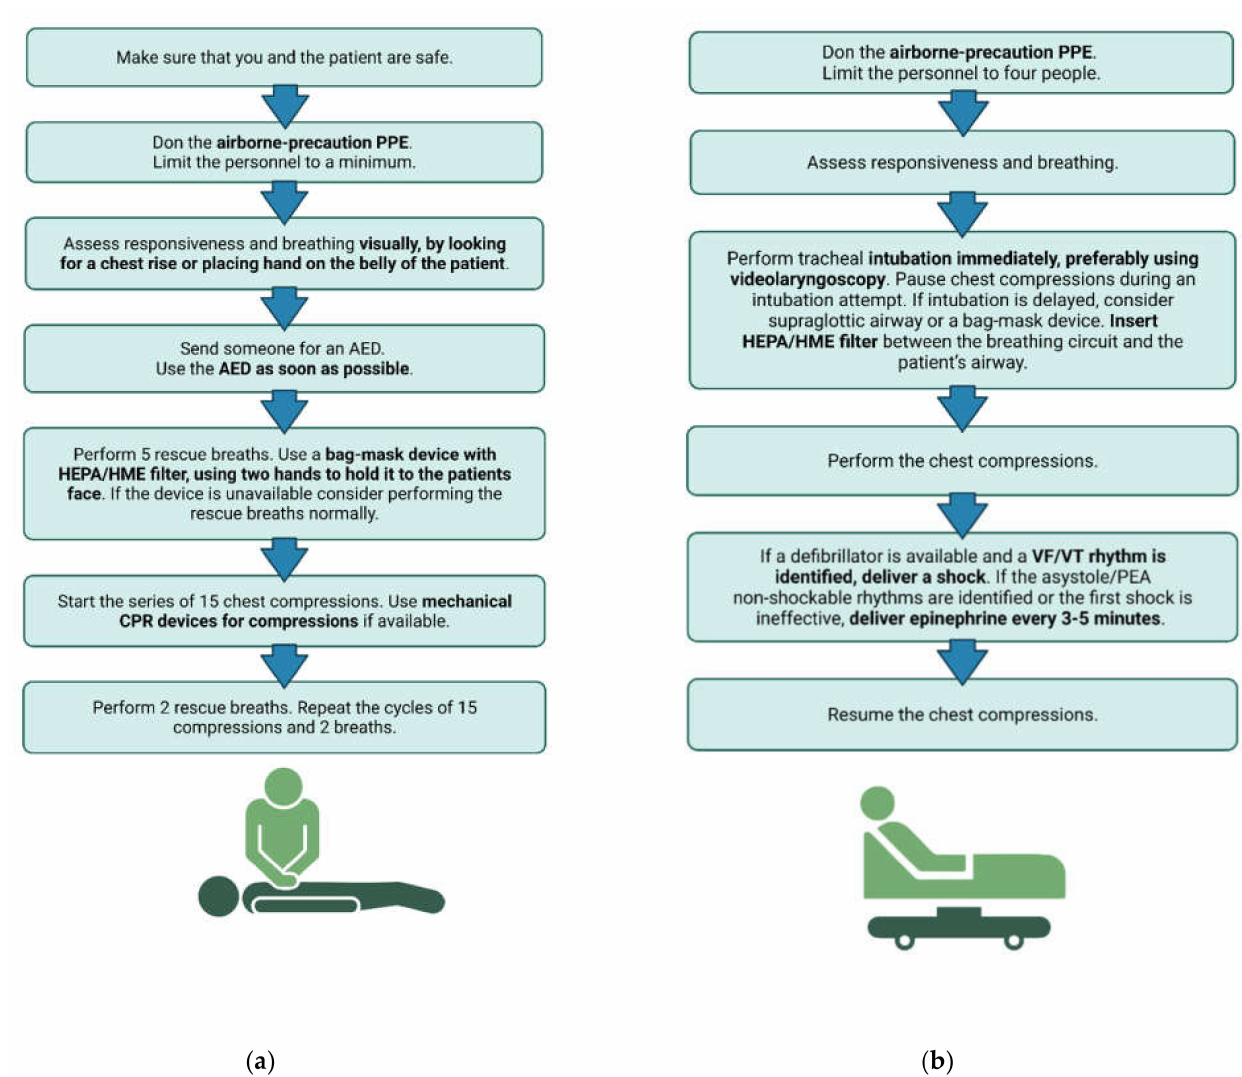
Figure 4. A summary of novel life support recommendations for pediatric patients. The modified recommendations are marked in bold. ( a ) Basic Life Support for pediatric patients. ( b ) Advanced Life Support for pediatric